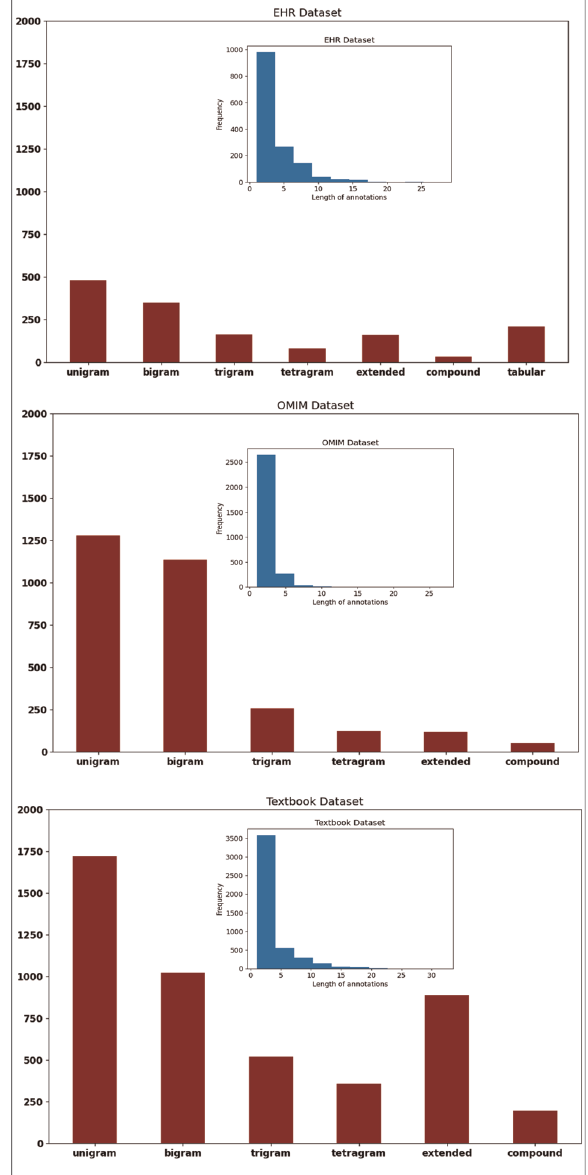
FIGURE 2 Text spans that identi fi ed clinical concepts were longer in the EHR corpus and shortest in the OMIM corpus (see blue inset histograms). Proportionately, the OMIM corpus used the most unigrams and bigrams as compared to the EHR corpus and the Textbook corpus (see red bar